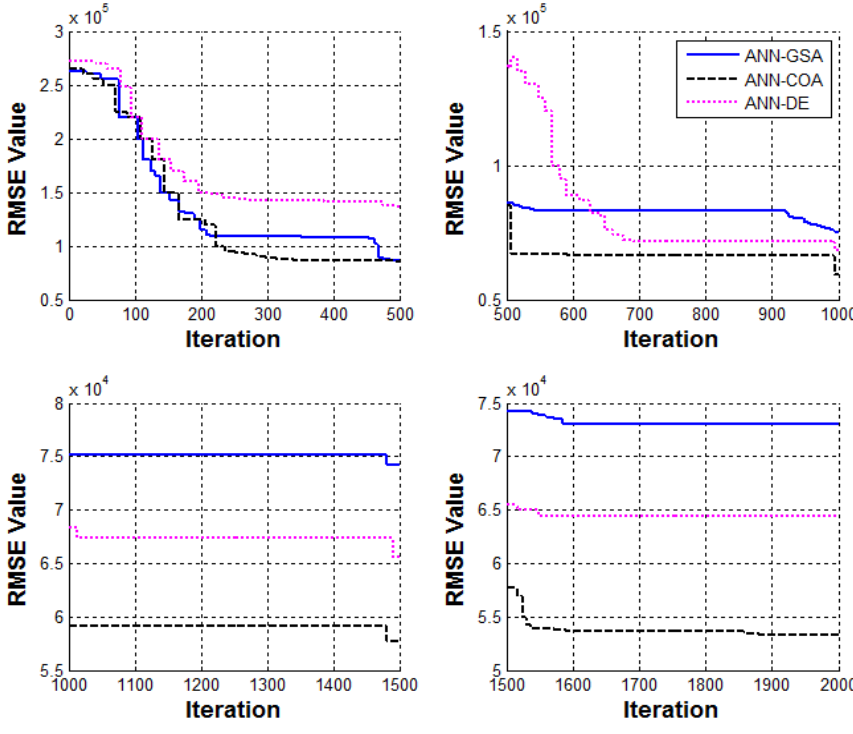
Figure 7. The forecasting performance of Artificial Neural Network trained by Gravitational Search Algorithm (ANN-GSA), Artificial Neural Network trained by Cuckoo Optimization Algorithm (ANN-COA), and Artificial Neural Network trained by Differential Evolution (ANN-DE).